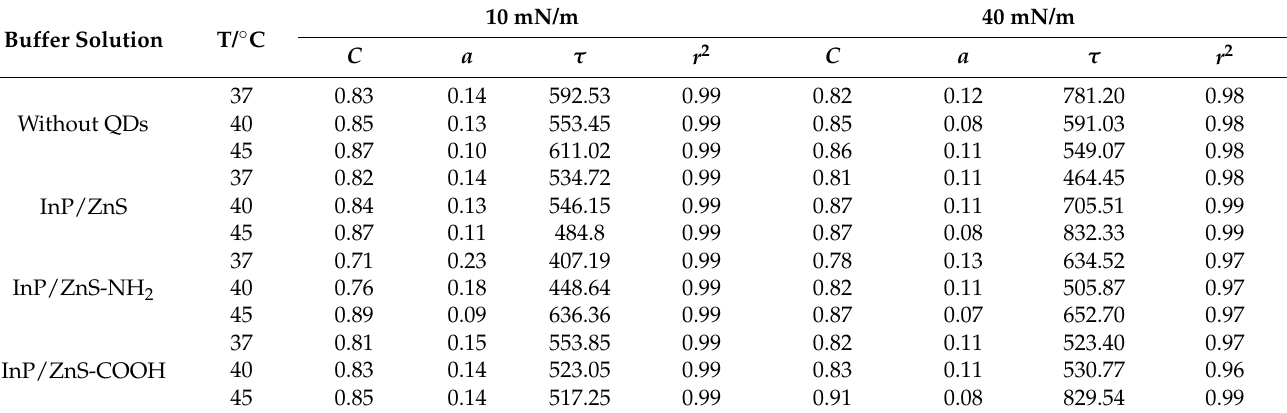
Table 2. The values of C , a , τ , r 2 , obtained by fitting the decay curves to a single-exponential